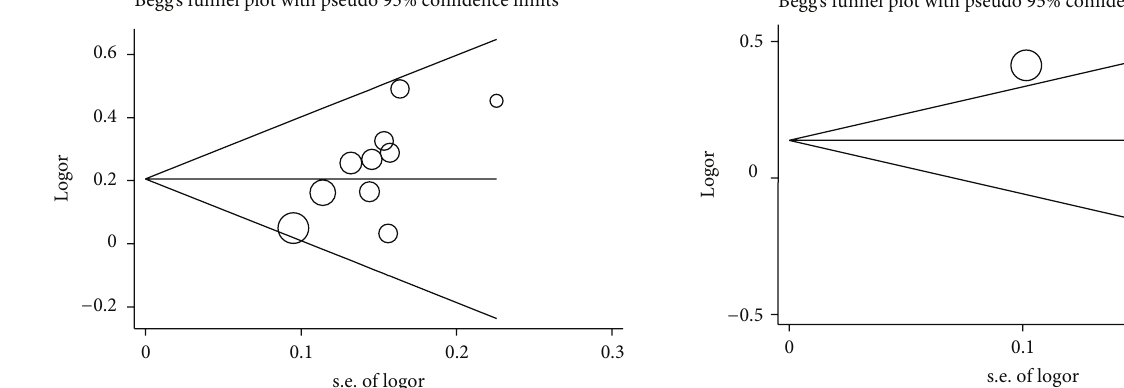
Figure 6: Funnel plot analysis to detect publication bias for GA + AA versus GG model of IL-17A rs2275913G > A polymorphism. Each point represents a separate study.